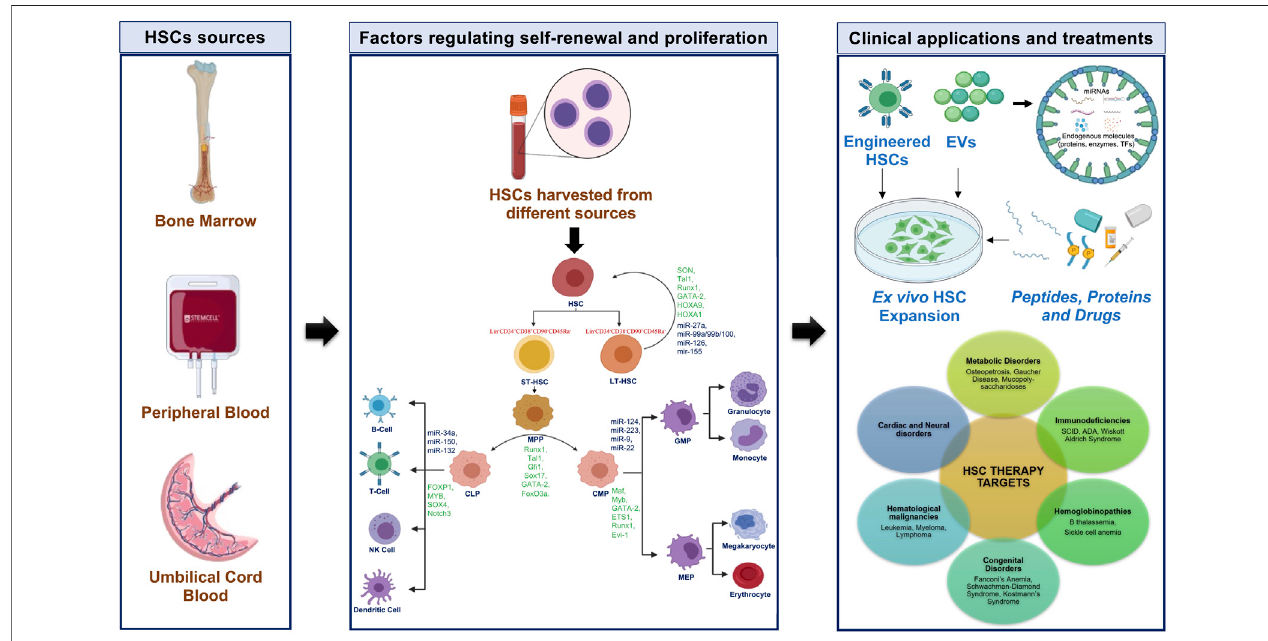
FIGURE 1 | Human hematopoiesis with characteristic markers, TFs, and miRNAs with potential approaches for HSCs in clinical applications. CLP-common lymphoidprogenitor;CMP-common myeloidprogenitor;EVs-extracellular vesicles; GMP-granulocyte-macrophageprogenitor;HSC-hematopoietic stemcell; LT-HSC- long-term HSC; MEP-megakaryocyte-erythrocyte progenitor; MPP-multipotent progenitor; NK-natural killer; ST-HSC-short-term HSC; TFs-transcription factors.